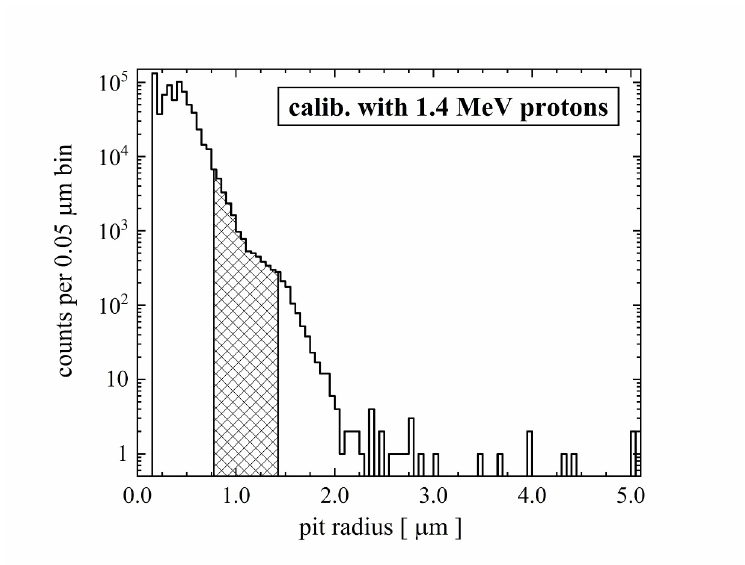
Figure 1. Calibration of solid state CR39 track detectors with 1.4 MeV protons, irradiated at the Weiz- mann Institute in 2016. Analysis of the solid state CR39 track detector plate used in [1], presented as a poster contribution at NIC2016 [10] and in a talk at the 2016 Fall Meeting of the APS Division of Nuclear Physics [11]. The RRI used for the cross section determination in [1] is indicated as shad- owed area. (This figure is the authors artwork prepared with information and materials available in the research